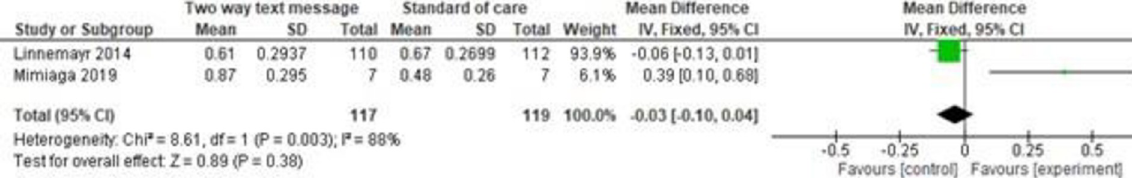
Fig 5. Forest plot of a sub-group analysis of two-way text message versus standard of care for ART adherence.